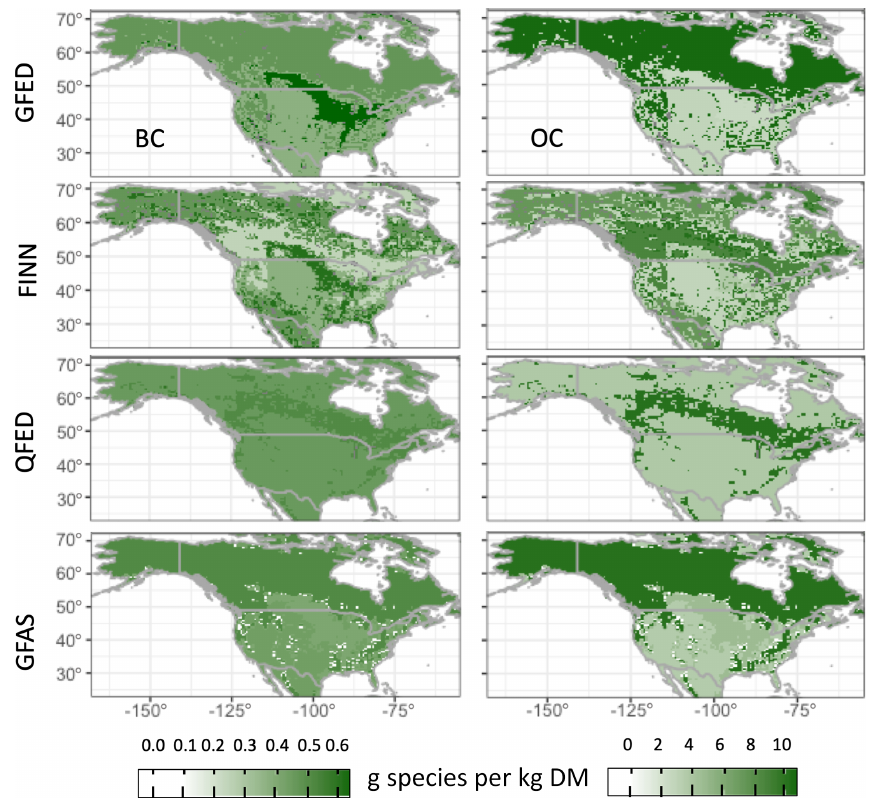
Figure 3. Emissions factors in g species per kg DM (shown only for vegetated land) for each inventory over North America; BC is shown on the left, and OC is shown on the right. Table 1. Emissions factors used in each inventory. Superscripted AM is from Andreae and Merlet (2001), Ak is from Akagi et al. (2011), An is Andreae and Rosenfeld (2008), and Mc is McMeeking et al. (2009). Note that QFED2.4 and GFAS1.2 EFs shown here for BC and OC are entirely from Andreae and Merlet (2001). ∗ The first QFED2.4 column shows the underlying EFs (shown in the second QFED2.4 column) multiplied by their biome-specific enhancement factor. We also adjust this factor down by the ratio of 1.4 (the OM:OC ratio used in the GEOS model) to the average OM:OC ratio used in GEOS-Chem in 2012 (see Sect. 2.2 for